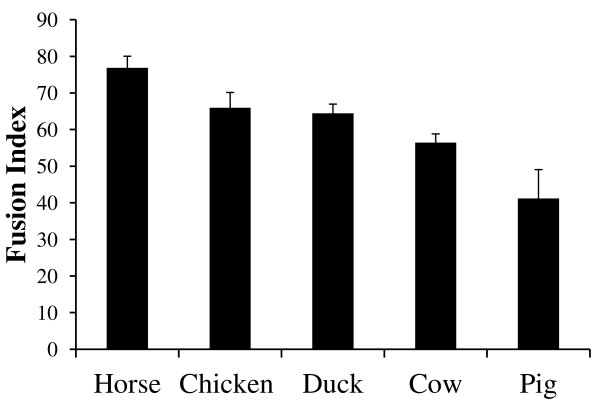
Fusion index in terminally differentiated primary avian and mammalian muscle cultures. Each species displayed a significantly different fusion index (p < 0.05) compared with other species, with the exception of the avian species (p > 0.7). Horse presented a significantly higher fusion index than all the species tested (p < 0.05). Remarkably, ≈77% of the equine cells fused into multi-nucleated myotubes. Porcine cells achieved the lowest level of fusion with ≈ 41% of the cells fusing into myotubes. The results were evaluated using a pairwise t test. Graph shows the mean fusion index with standard deviation.